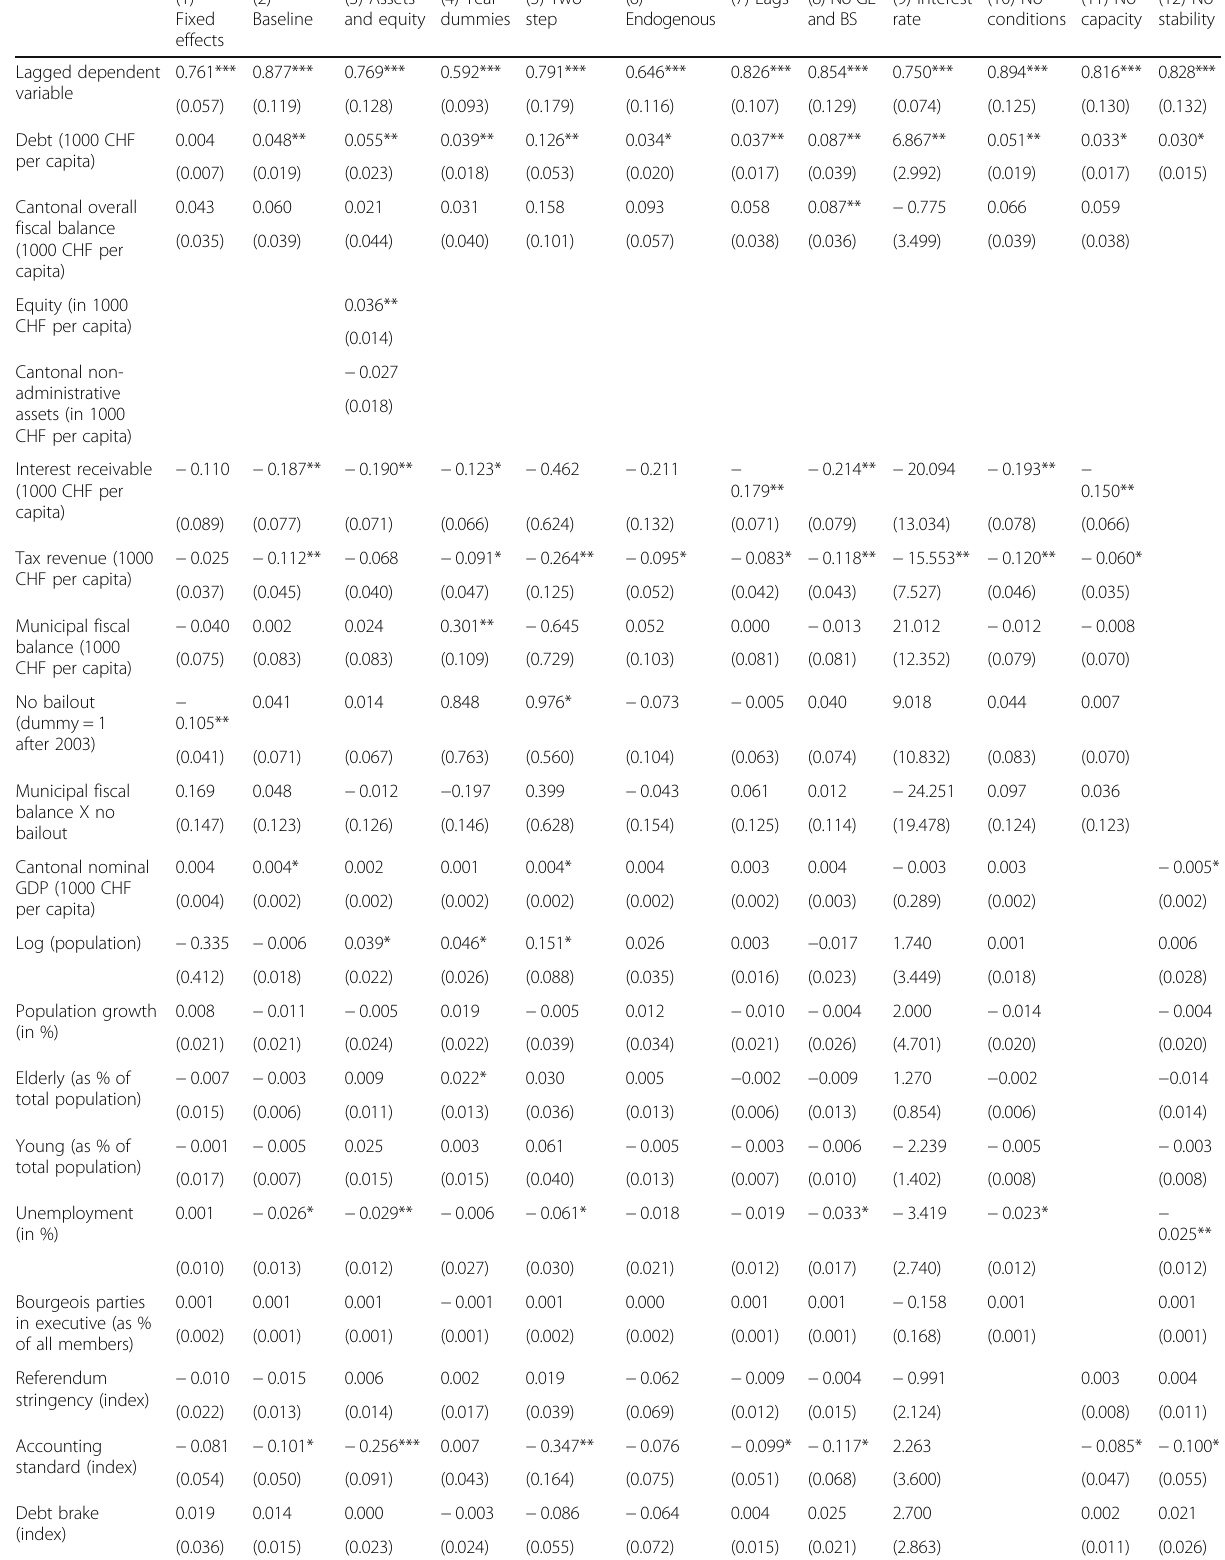
Table 1 Regression